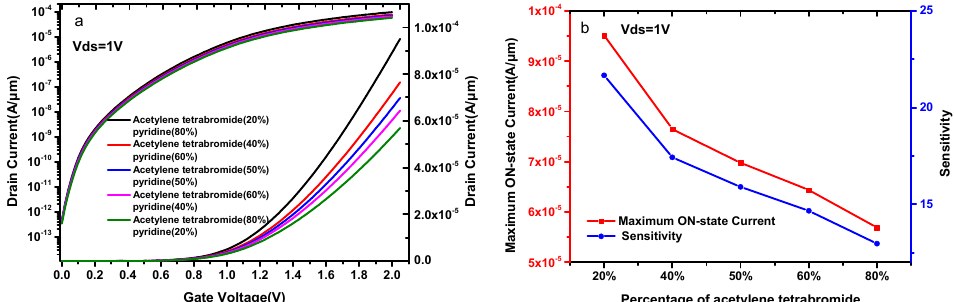
2.010 0.0 0.2 0.4 0.6 0.8 1.0 1.2 1.4 1.6 1.8 Figure 8. ( a ) Transfer characteristics of DMG-HJLTFET for different contents of acetylene tetrabromide and pyridine; ( b ) the variation of the maximum ON-state current and sensitivity for different contents of acetylene tetrabromide and pyridine.